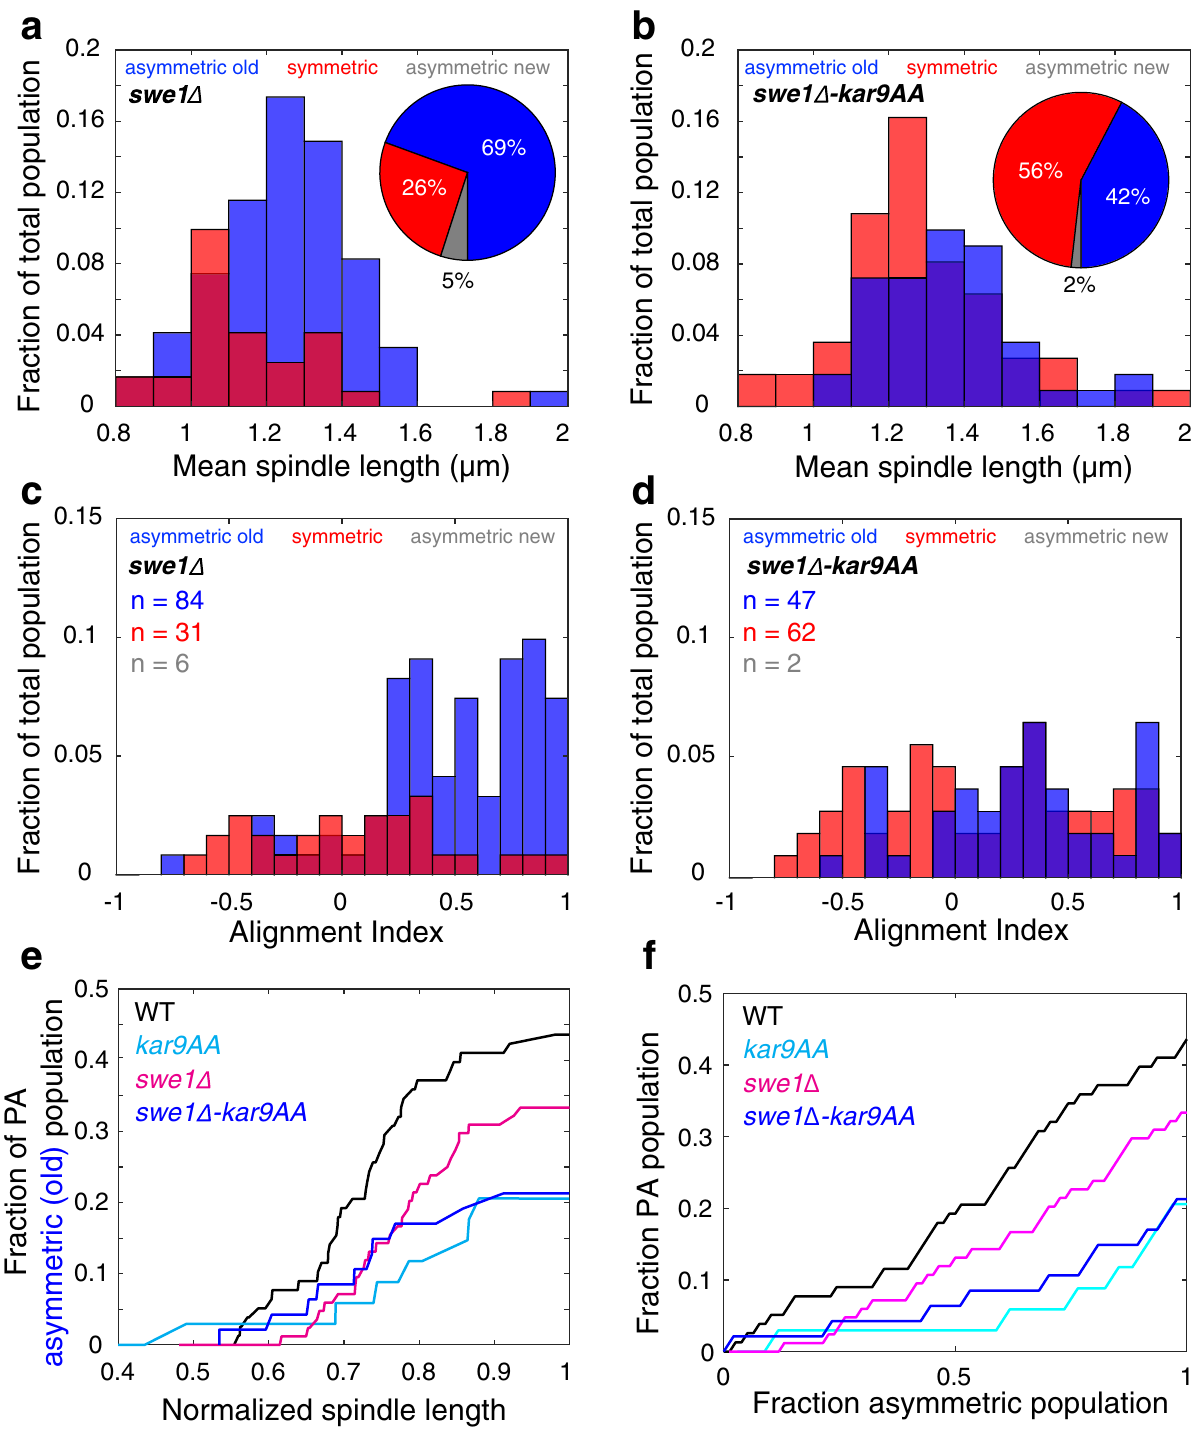
Figure 4. Swe1 acts to regulate symmetry breaking independently of the Cdk1-Kar9 pathway. ( a , inset) swe1∆ cells display increased asymmetry in the population relative to WT. ( a ) Deletion of Swe1 results in early symmetry breaking. ( b , inset). Deletion of Swe1 partially rescues the symmetry breaking defect in the kar9-AA population. ( b ) Symmetry breaking occurs at random in the double mutant. ( c ) Asymmetric swe1∆ cells are biased toward alignment but are less efficient that WT asymmetric cells. ( d ) Asymmetric cells in the double mutant population are broadly distributed along a large range of AI values indicating a poor ability to align themselves. ( e ) Cumulative percentage of PA spindles in asymmetric populations as a function of increasing spindle length, which is a proxy for time spent in metaphase. Over time, WT asymmetric spindles achieve perfect alignment more efficiently than the swe1∆ mutant and swe1∆; kar9-AA double mutant. A small population of PA asymmetric kar9-AA cells emerges later in metaphase. ( f ) The correlation between perfect alignment and asymmetry is reduced in the swe1∆ mutant relative to WT. The swe1∆; kar9-AA double mutant behaves similarly to kar9-AA